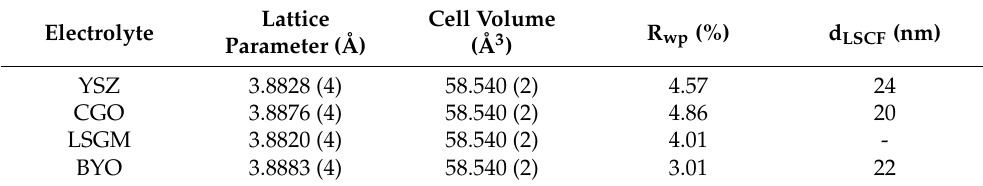
Figure 1. Rietveld refinement of LSCF electrode deposited onto different electrolytes at 700 °C, ( a ) Zr 0.84 Y 0.16 O 1.92 (YSZ), ( b ) Ce 0.9 Gd 0.1 O 1.95 (CGO), ( c ) La 0.9 Sr 0.1 Ga 0.8 Mg 0.2 O 2.85 (LSGM) and ( d ) Bi 1.5 Y 0.5 O 3 (BYO). Table 2. Structural and microstructural parameters of LSCF cathode deposited onto different elec- trolytes by